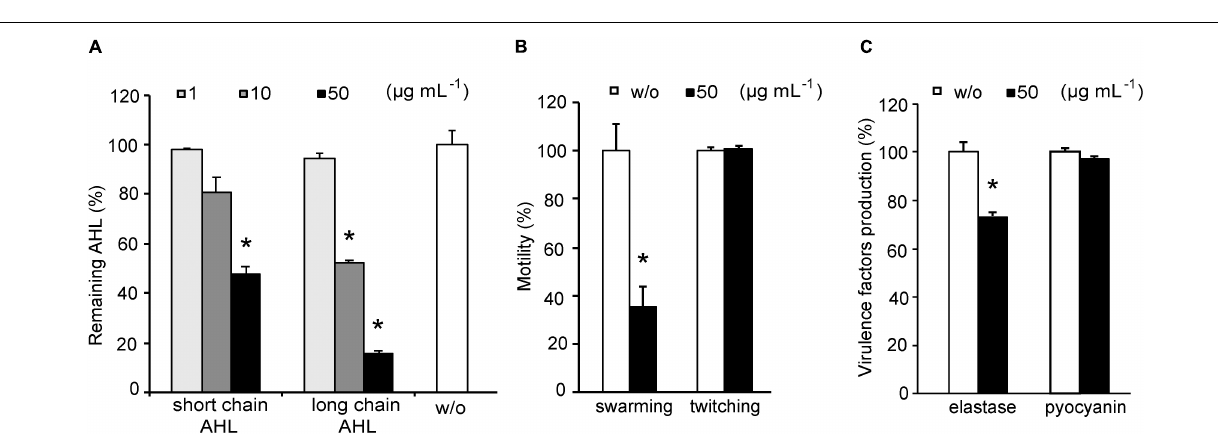
FIGURE 4 | Effects of YtnP-ZP1 on P. aeruginosa PAO1 lactones (A) , motility (B) , and on elastase and pyocyanin production (C) . Values are plotted relative to buffer-treated control (w/o) and are representative of three independent experiments ± SD. * P <